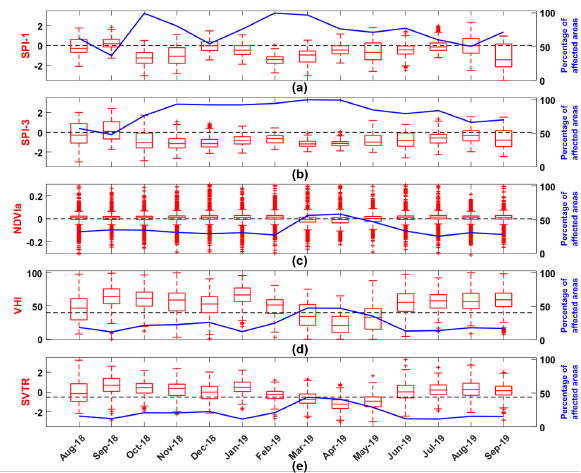
Figure 5. Boxplots of the drought indices within the 14-month period which includes the pre-drought, during drought, and post-drought events.